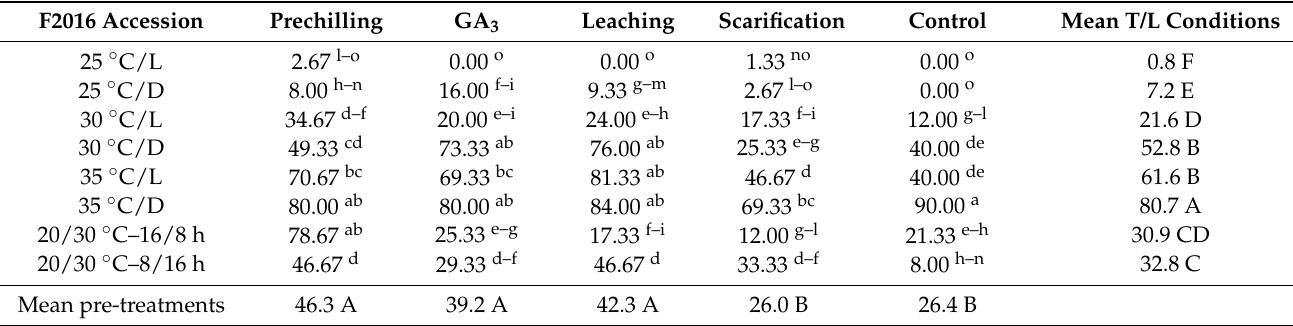
Table 3. Effect of the pre-germination treatments (A), temperature/light conditions (B), and their reciprocal interactions (A × B) on germination percentage of P. incarnata F2016 accession.